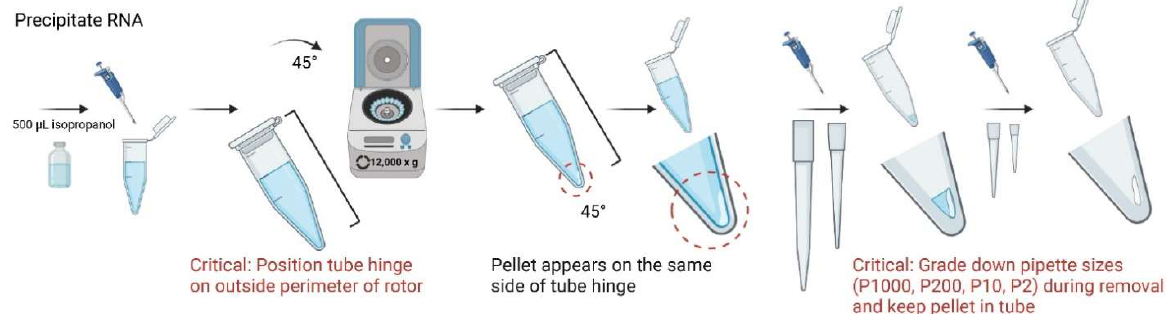
Figure 6. Schematic workflow of critical step in removal of supernatant and keeping clear RNA pellet in tube during RNA extraction of isolated microglia and astrocytes.